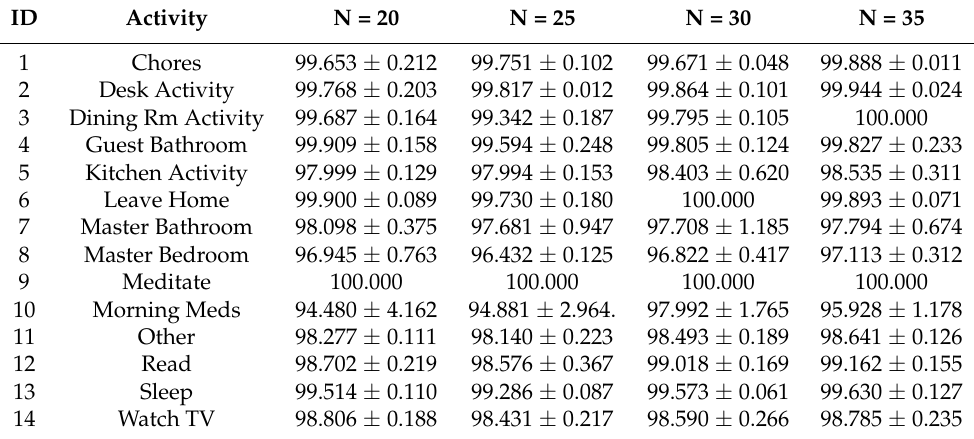
Table 6. The F 1 - score ( % ) (mean ± 3 σ ) of different activities of TLGAT in the MILAN dataset.